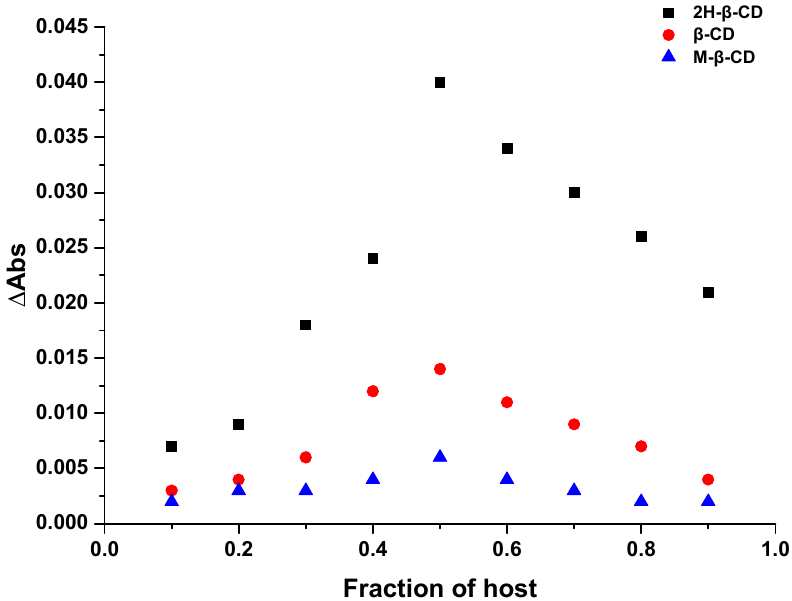
Figure 2. Job’s plot of 2H- β -CD, β -CD, and M- β -CD with